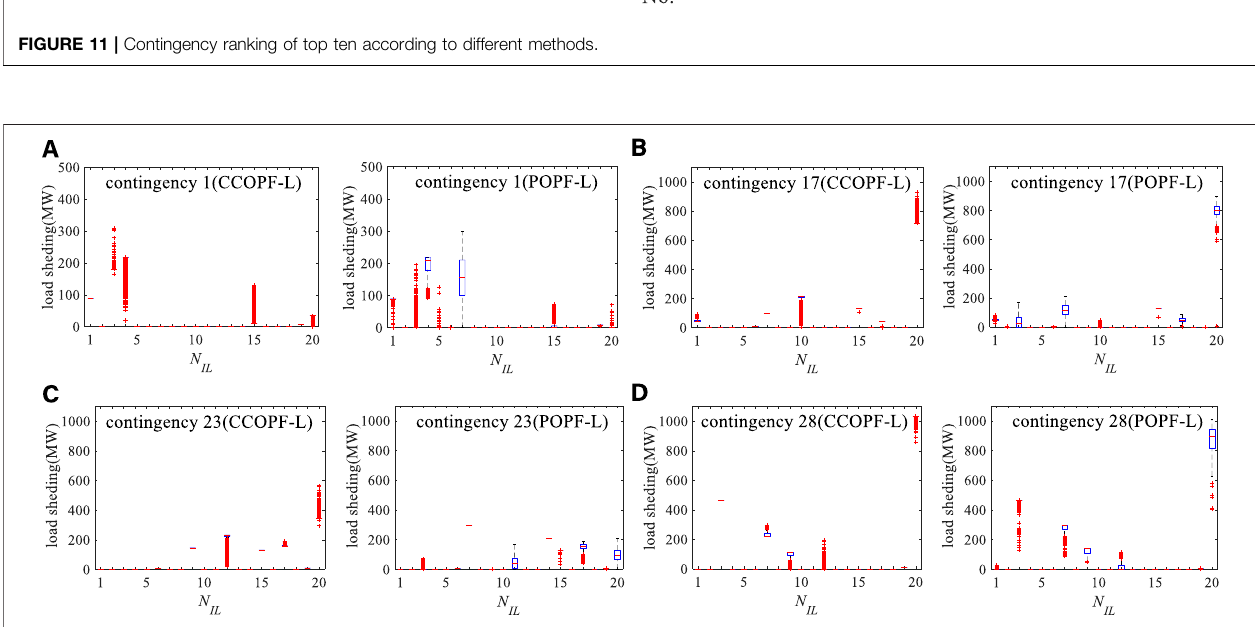
FIGURE12| Optimalloadsheddingschemesofdifferentcontingencies. (A) Optimalloadsheddingschemesofcontingency1. (B) Optimalloadsheddingschemes of contingency 17. (C) Optimal load shedding schemes of contingency 23. (D) Optimal load shedding schemes of contingency